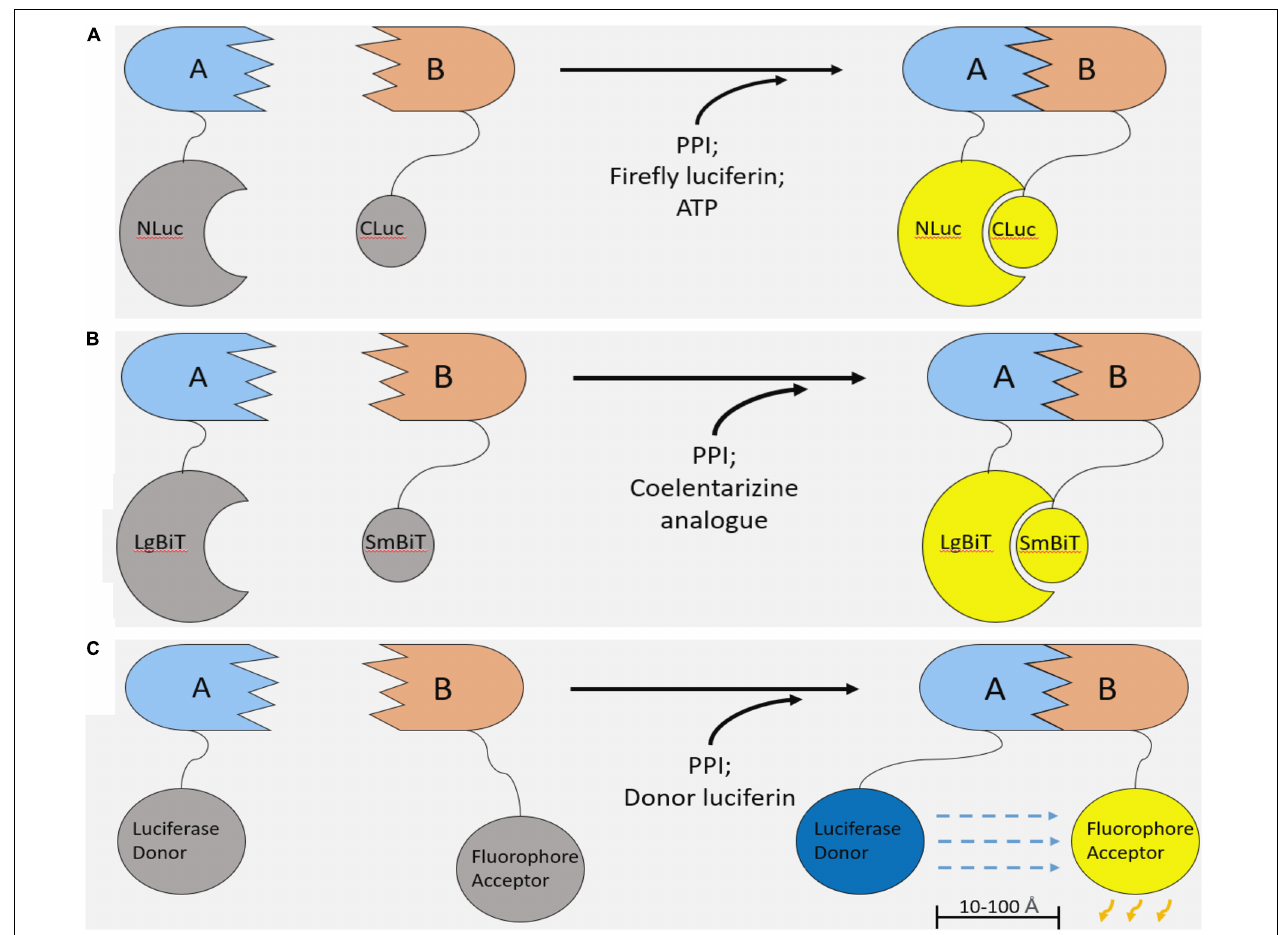
FIGURE 2 | Luciferase-based methods of studying protein–protein interaction. (A) Firefly Luciferase complementation system. Two components of the firefly luciferase are fused with two interacting proteins. Upon PPI between the fusion proteins, luciferase complementation occurs, and, in the presence of a luciferin substrate and ATP, light is emitted. (B) NanoBiT system. The NanoBiT system is a split luciferase technology derived from a deep-sea shrimp. It is comprised of the 18kDa LgBiT and 1.3 kDa SmBiT. The main advantages of NanoBiT over other split luciferase systems are its small size, high sensitivity, and improved thermal stability. (C) Bioluminescence resonance energy transfer (BRET). Like split luciferase complementation assays, BRET is another mechanism of quantifying PPIs in real time. A functional luciferase donor and fluorophore acceptor are fused onto an interacting pair of proteins. Upon PPI, the fluorophore and luciferase are